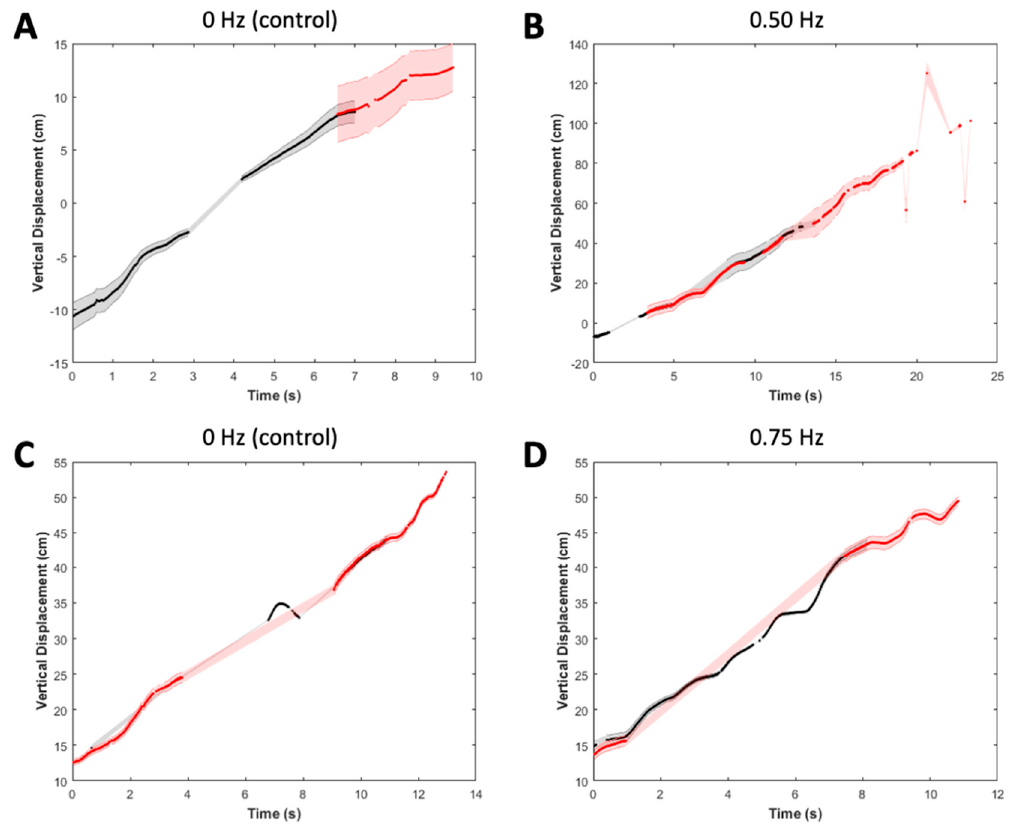
Figure A3. Displacements over time for jellyfish, animal 2, for the swim controller frequencies ( A ) and ( C ) 0 Hz, ( B ) 0.50 Hz, and ( D ) 0.75 Hz. Vertical displacement over time of the jellyfish with respect to the rope, with the error propagated from conversions in pixel space to centimeter space, assuming pixel-level accuracy in centroids. Tracks were assembled by stitching vertical positions using both red and yellow markers (shown in red and black, respectively), to show accuracy in overlap.